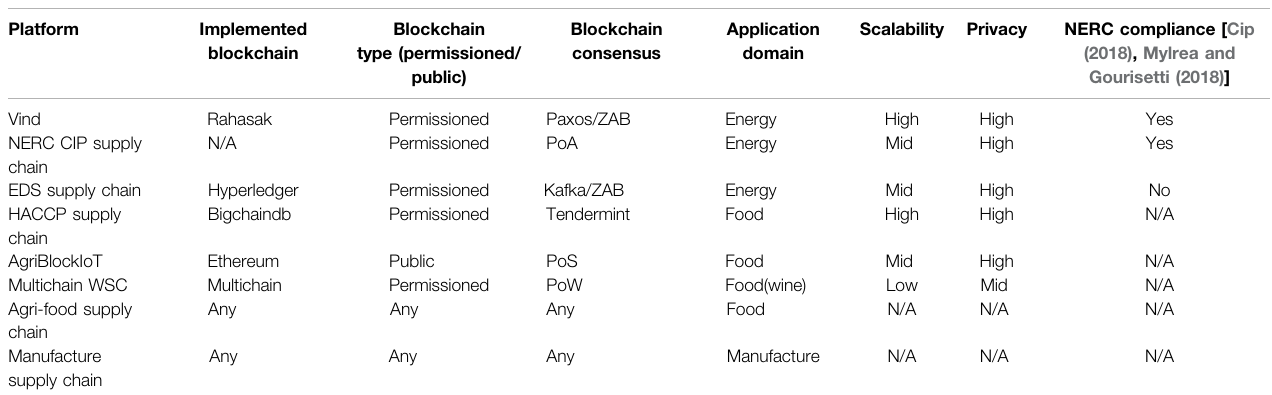
TABLE 1 | Blockchain platform